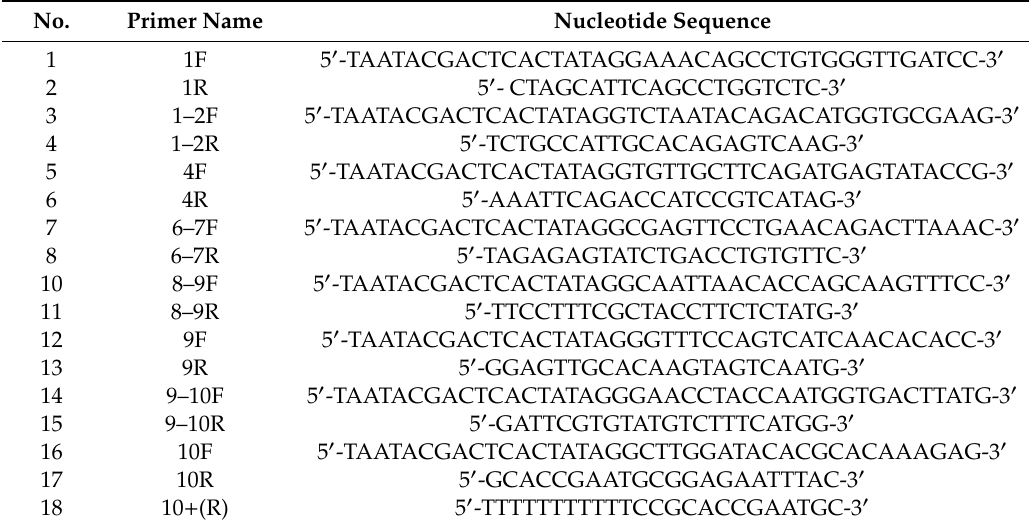
Table 1. Primers used in this study. F-used as forward primers; R-used as reverse primers, also 5 (cid:48) -fluorescently labeled with VIC, FAM, PET, or NED where indicated.